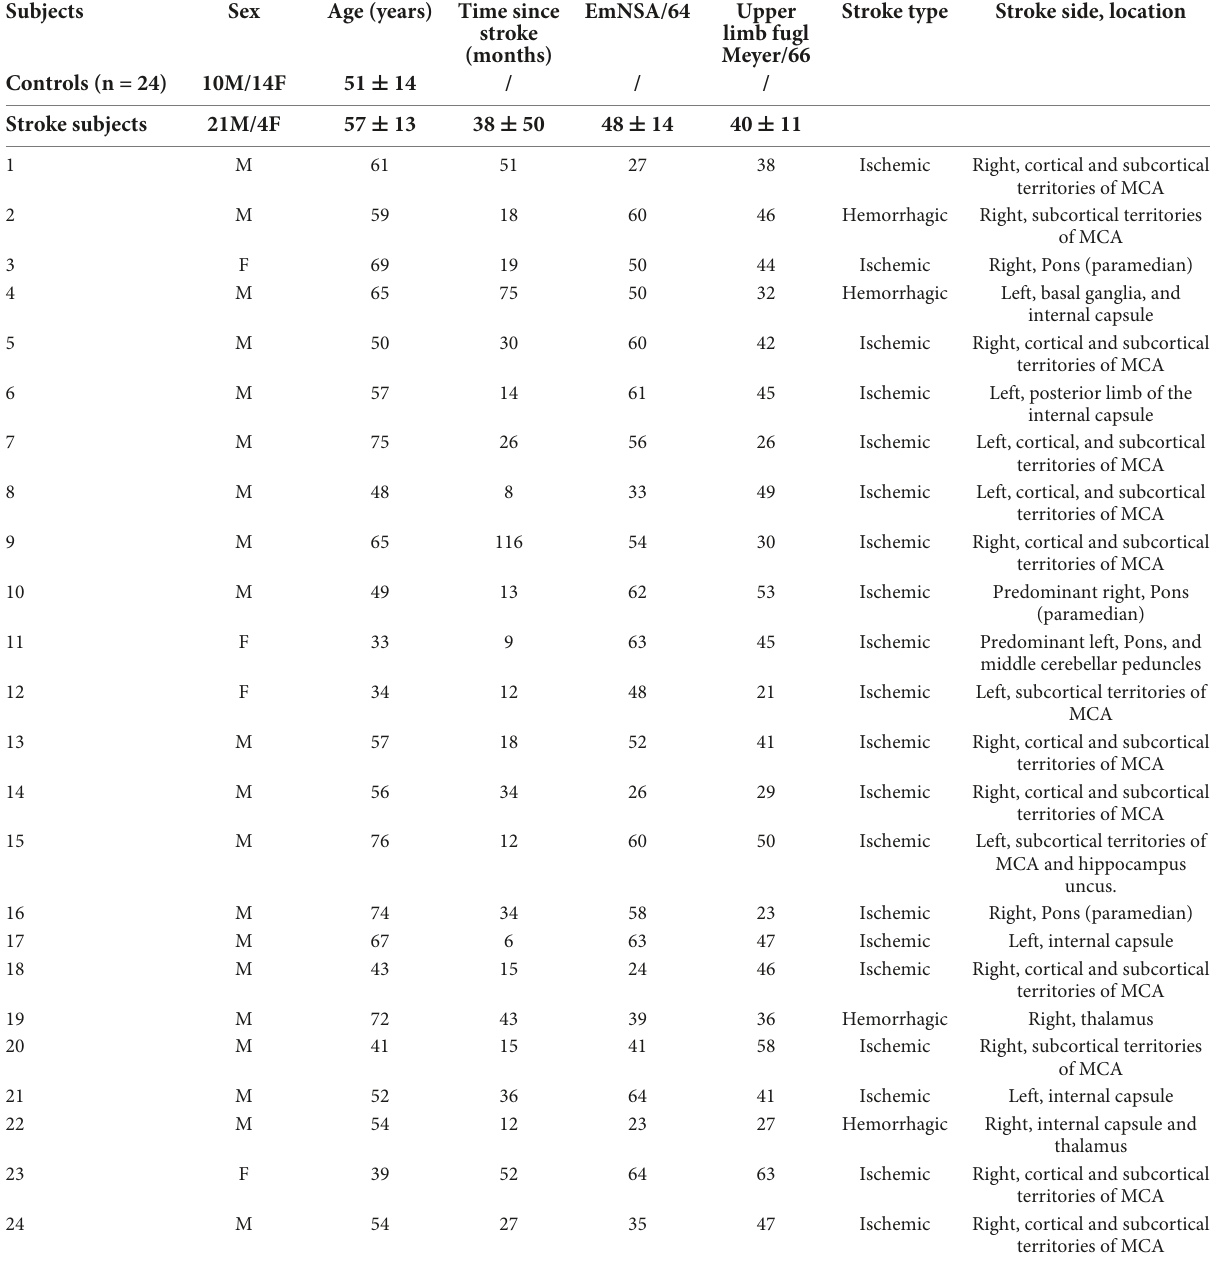
TABLE 1 Detailed demographics and clinical of